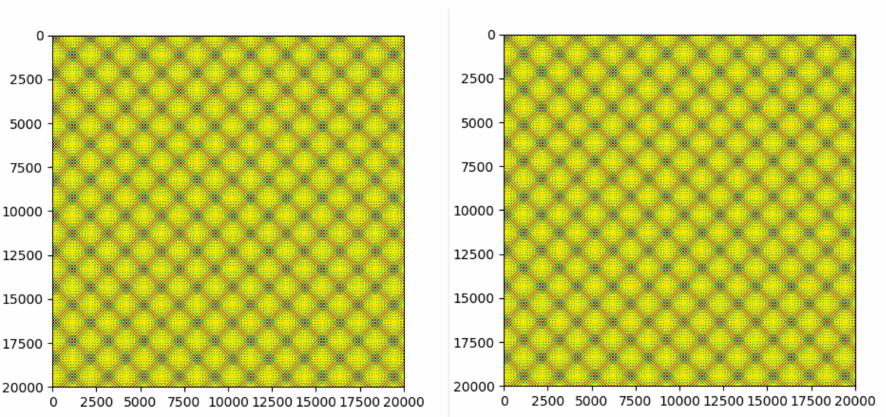
Figure 2. Recurrence plots before signal preprocessing. Left: recurrence plot for fault condition (bearing axis deviation) motor. Right: recurrence plot for healthy condition